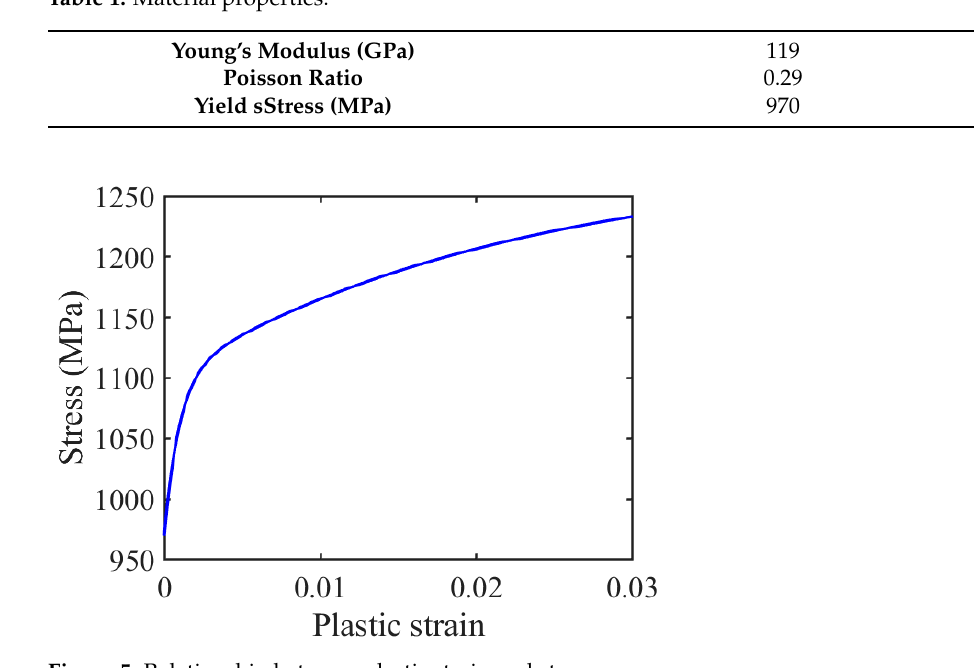
Figure 6. FE model of fretting wear, ( a ) globale view and ( b ) zoom at contact The normal load and slip between the two contact parts are both relatives. To sim- plify the model, we apply the normal load and oscillatory displacement on the top center of the cylindrical pad. The loading history is shown in Figure 7. In one cycle, there are